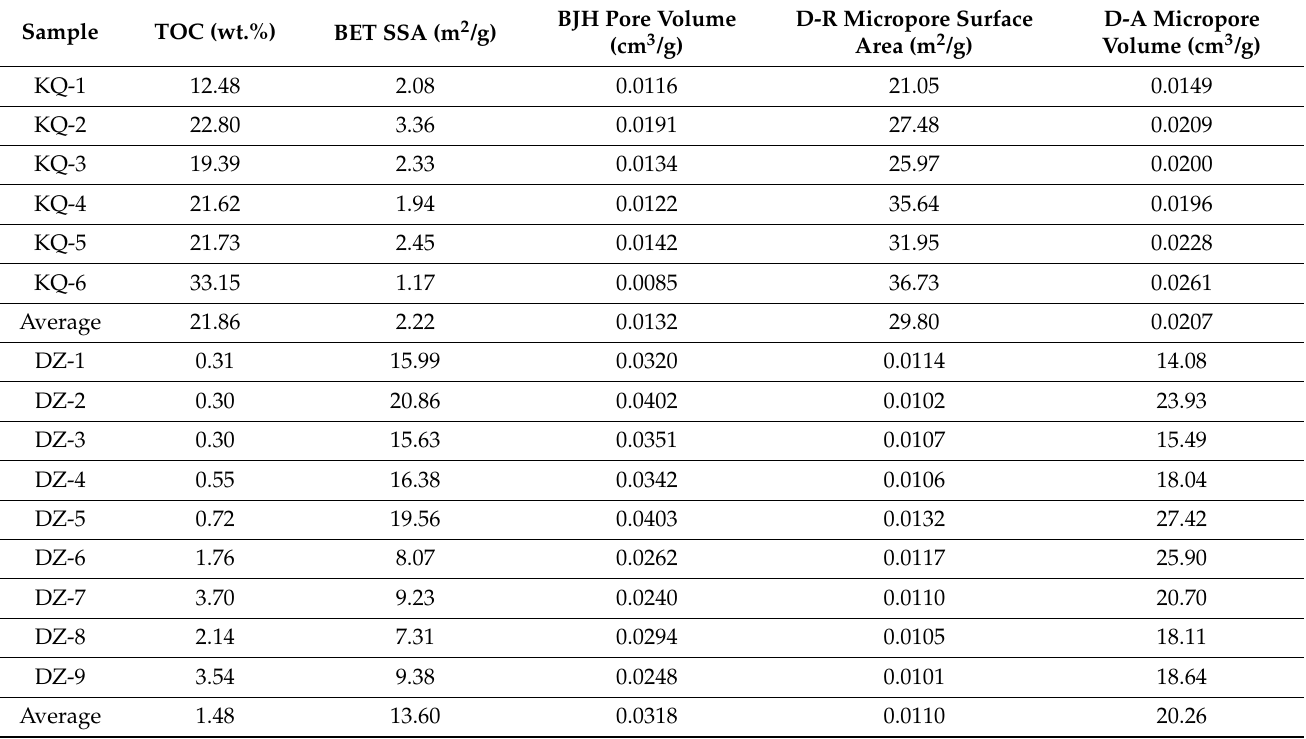
Table 2. Pore structure characteristics of shales determined by low-pressure N 2 and CO 2 adsorption.